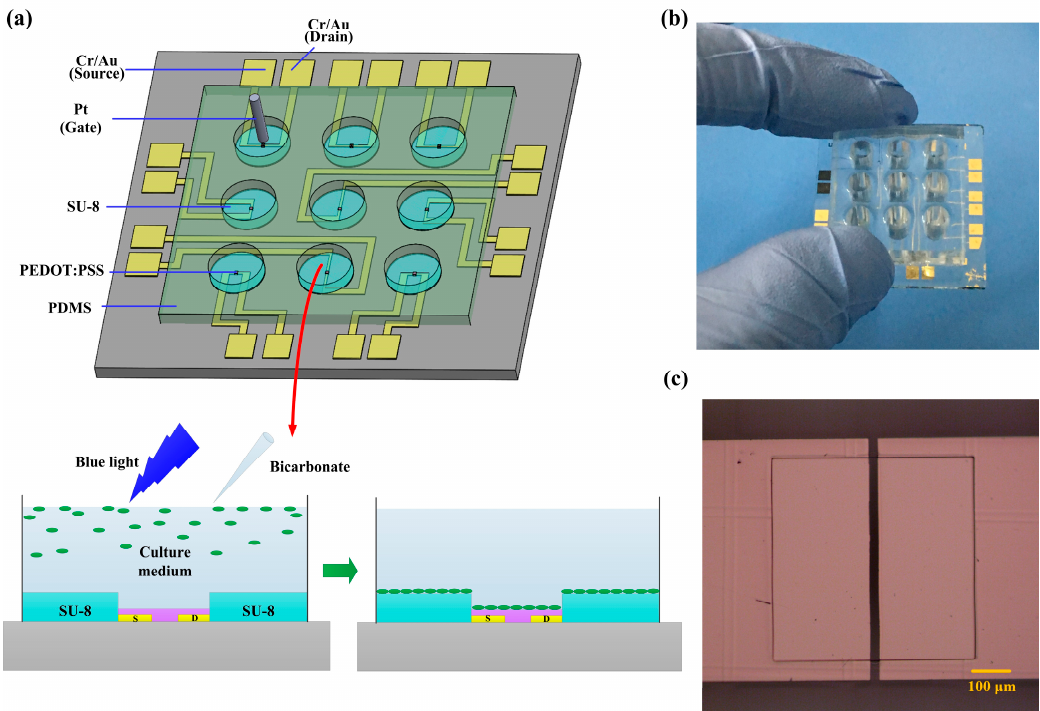
Figure 1. ( a ) The schematic diagram of an OECT array-based measuring platform. For the platform, the yellow region represented Cr/Au electrodes, the grey pillar represented gate electrode, the blue region represented SU-8, the pink region represented PEDOT:PSS, the green region represented PDMS, and the grey block represented glass substrate, the OECT device was characterized before and after the transition of H. pluvialis from motile to precipitate phase, in which the culture medium served as the electrolyte; ( b ) Photograph of the OECT array platform; ( c ) Microscopic image of the SU-8